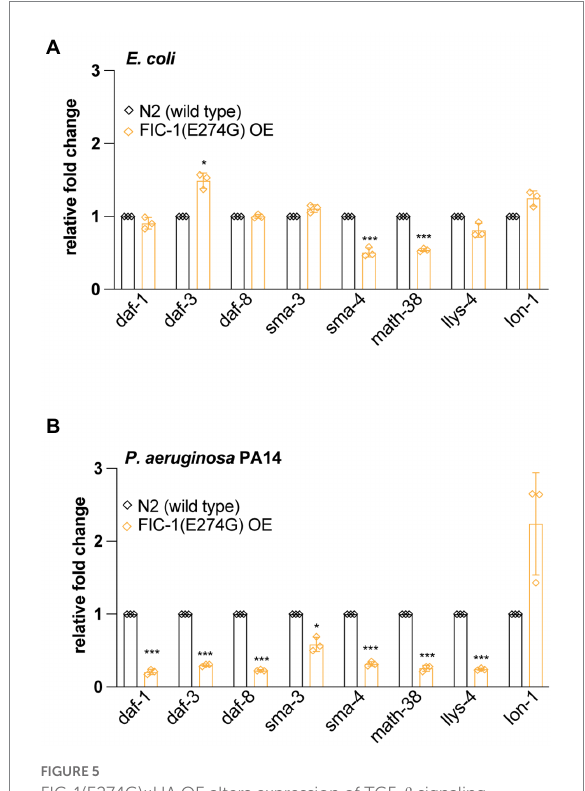
FIGURE 5 FIC-1(E274G)::HA OE alters expression of TGF- β signaling components. Uninduced and induced N2 wild type and FIC- 1(E274G)::HA OE strains were kept on E. coli (A) and P. aeruginosa PA14 (B) plates and thereafter collected. Following RNA extraction, gene expression of indicated genes was determined by qPCR. Experiment was performed in triplicate with >200 animals per replicate/condtion. Error bars represent SD.